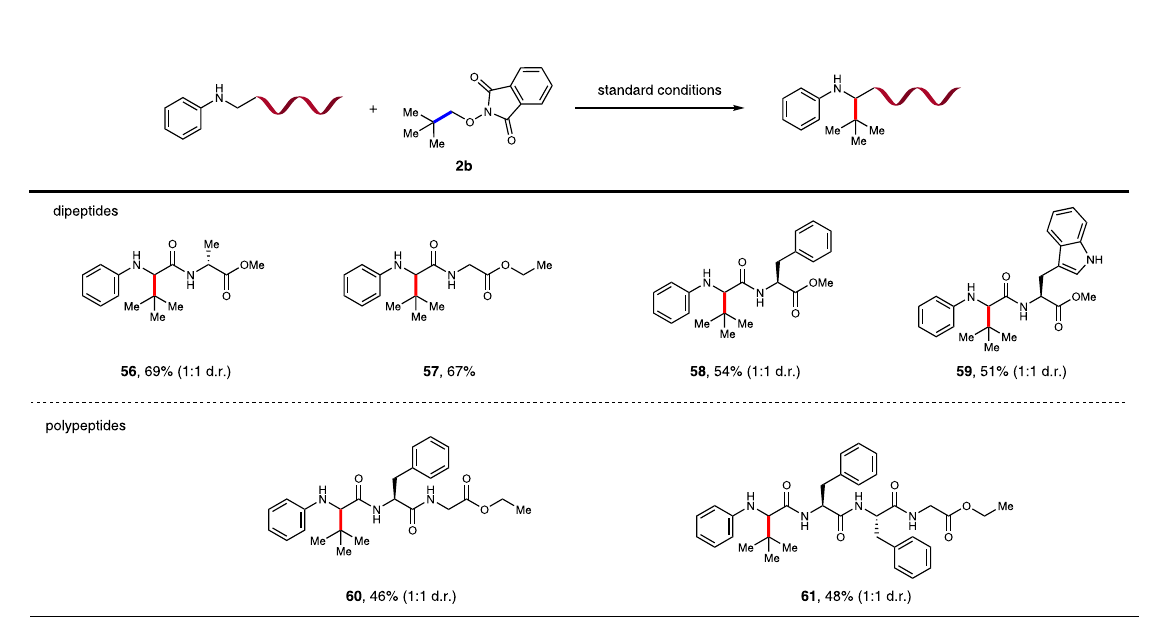
Fig.5|Scopeofpeptides. Conditions:Allreactionswerecarriedoutwith4CzIPN(5mol%),peptide(0.2mmol), 2b (0.1mmol),andDMSO(0.03M)irradiated under15W Blue LEDs at 60°C.